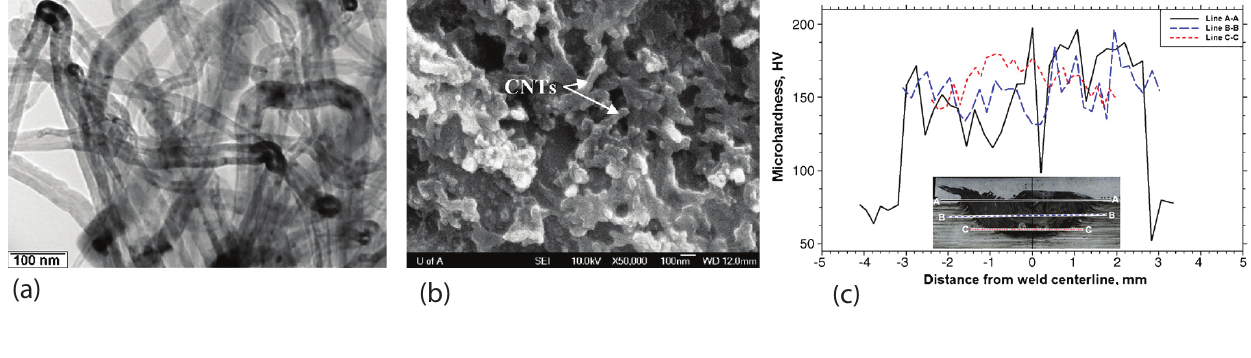
Figure 8 . Morphology and hardness profile of friction stir processed carbon nanotube reinforced composite (after Lim et al. [14]): (a) TEM image of multi-walled carbon